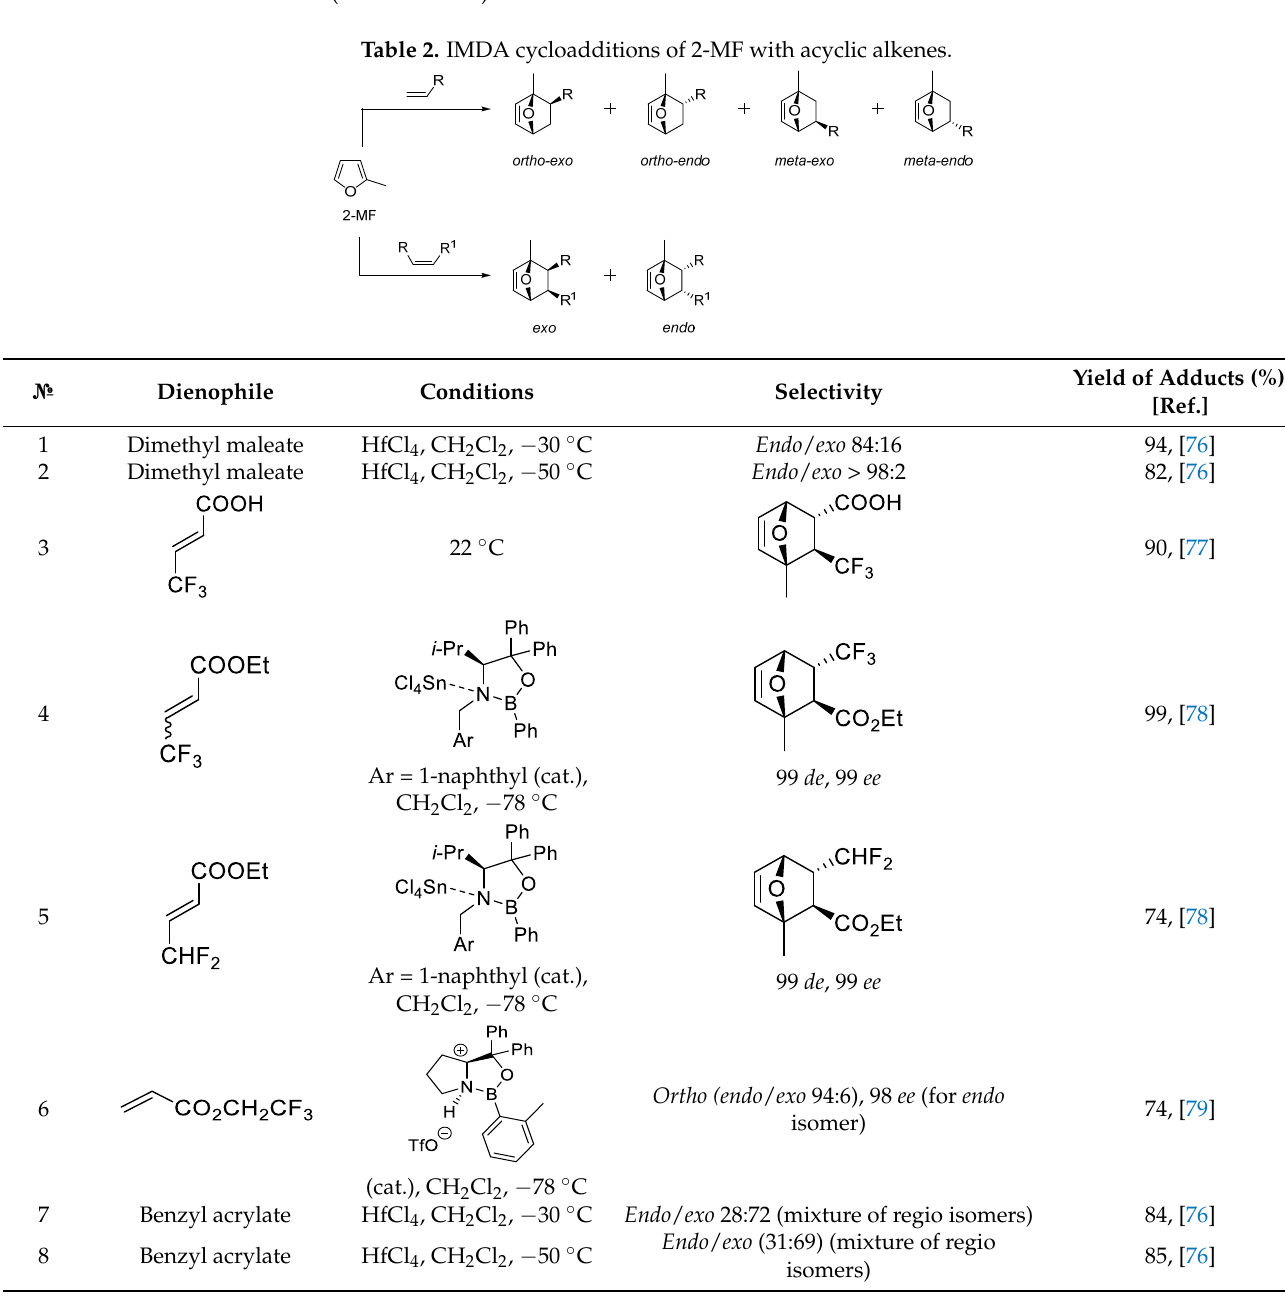
Table 2. IMDA cycloadditions of 2-MF with acyclic alkenes.